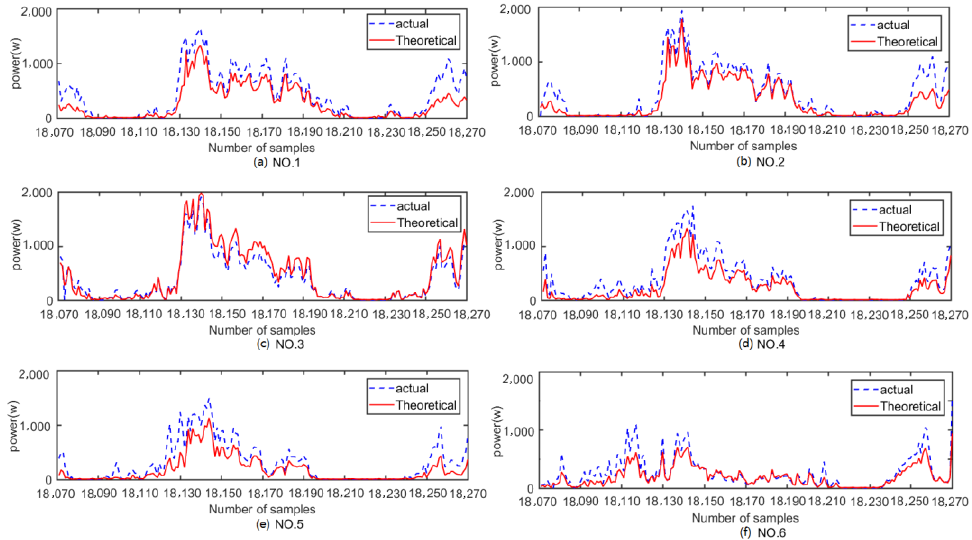
Figure 12. The actual power and theoretical power of anemometers for six wind turbines in 2016: ( a ) Power curve of WTG1; ( b ) Power curve of WTG2; ( c ) Power curve of WTG3; ( d ) Power curve of WTG4; ( e ) Power curve of WTG5; ( f ) Power curve of WTG6